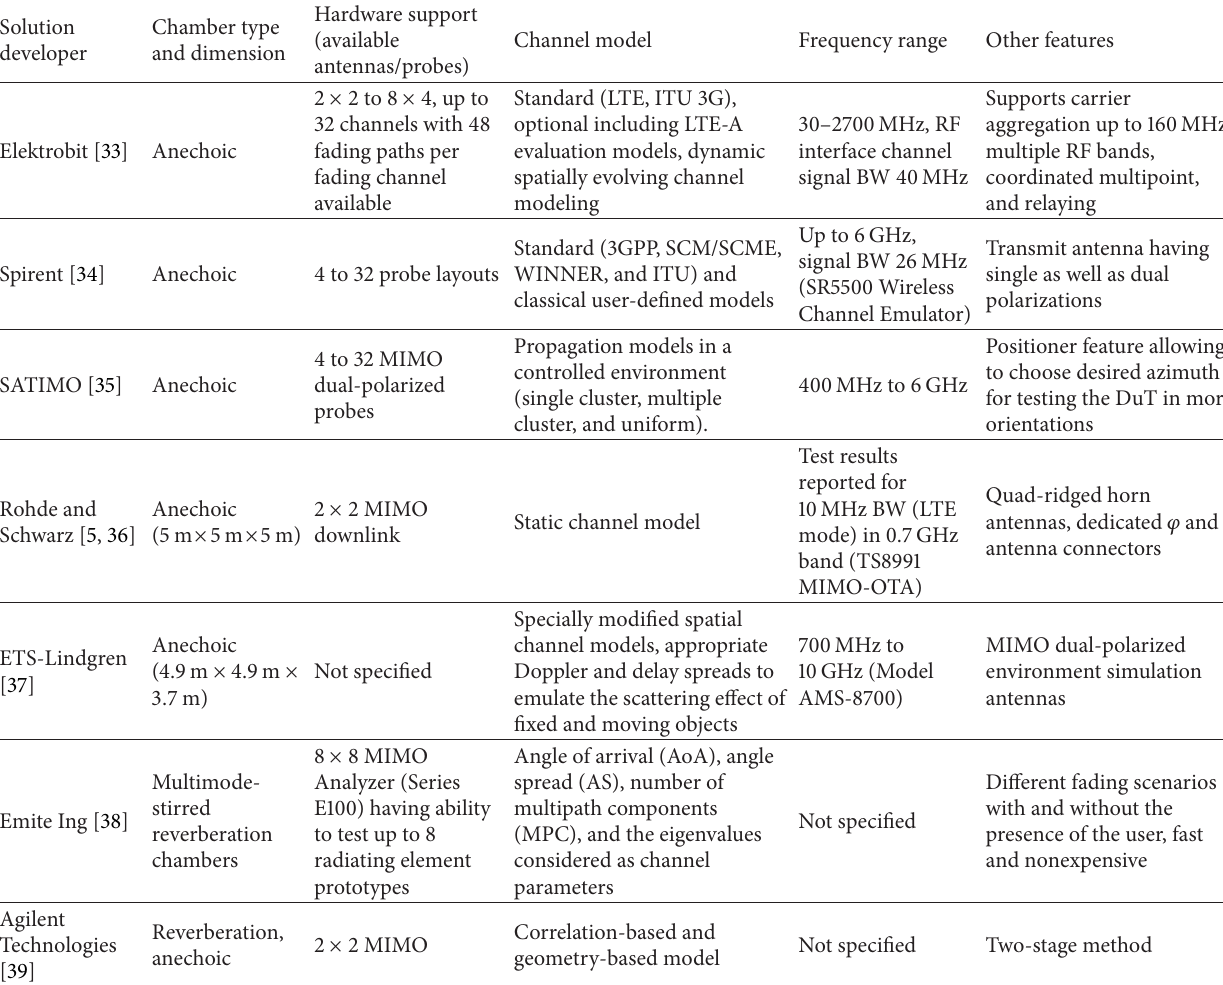
Table 1: Summary of some available OTA test